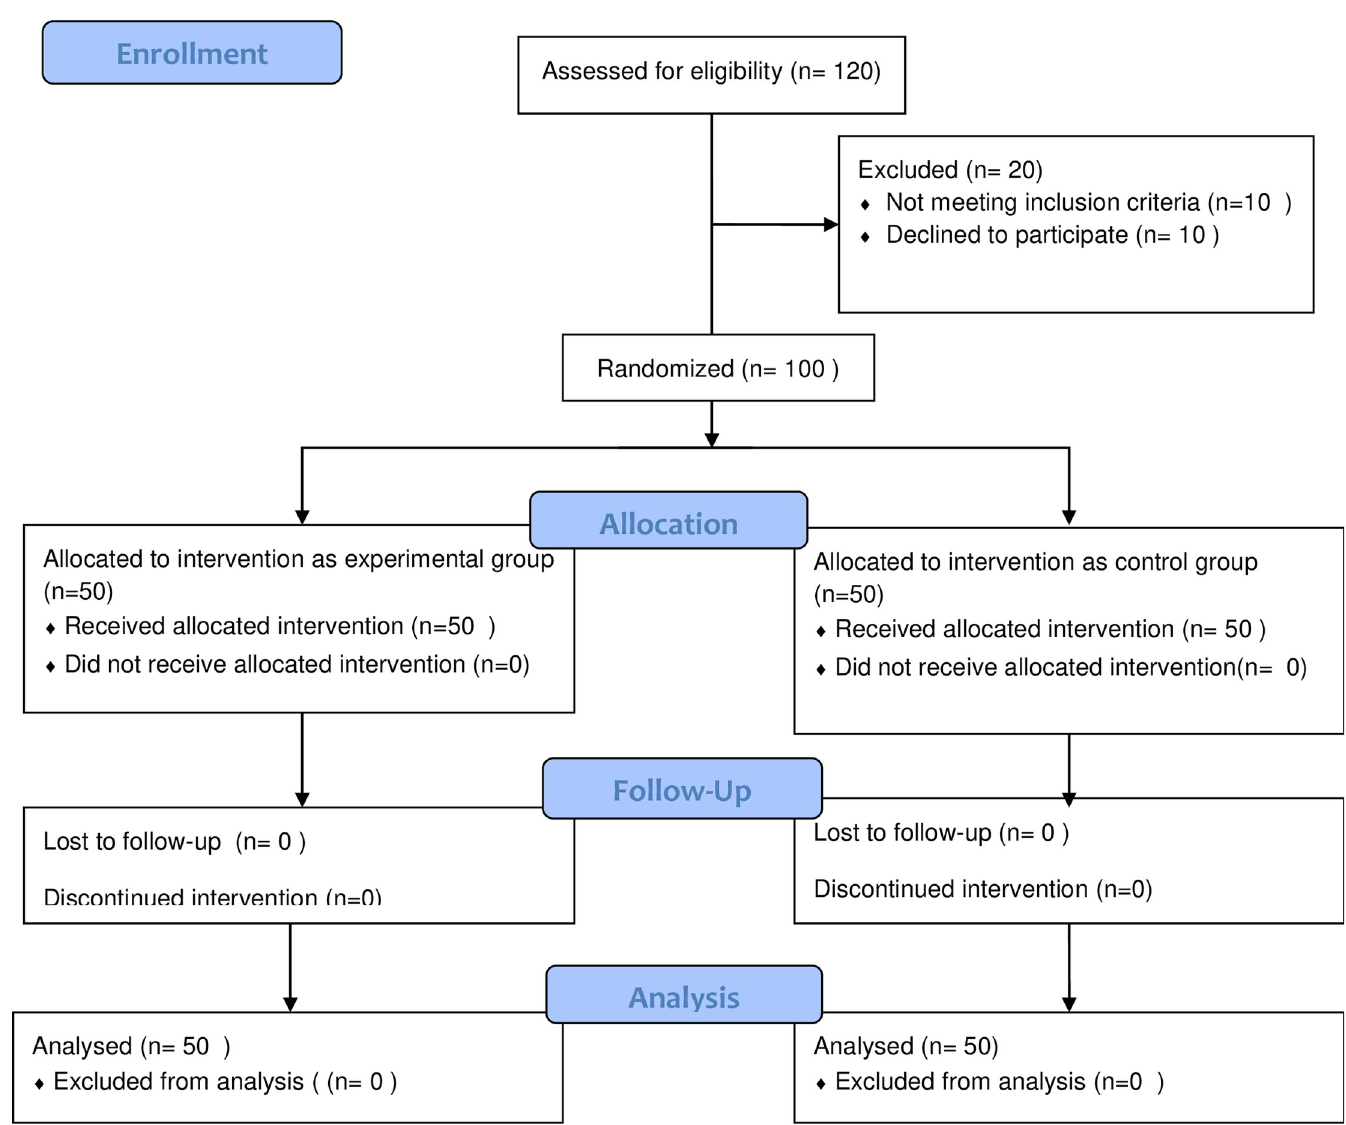
Fig 1. Enrollment flow